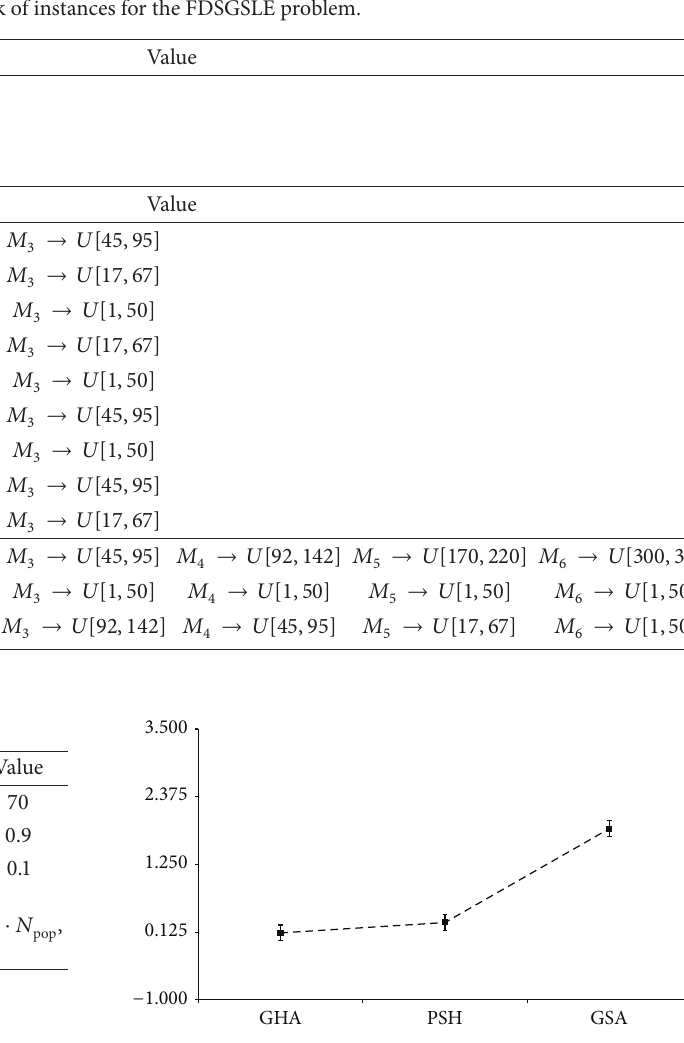
Figure 4: Means plot with 95% LSD intervals obtained for 2- machine